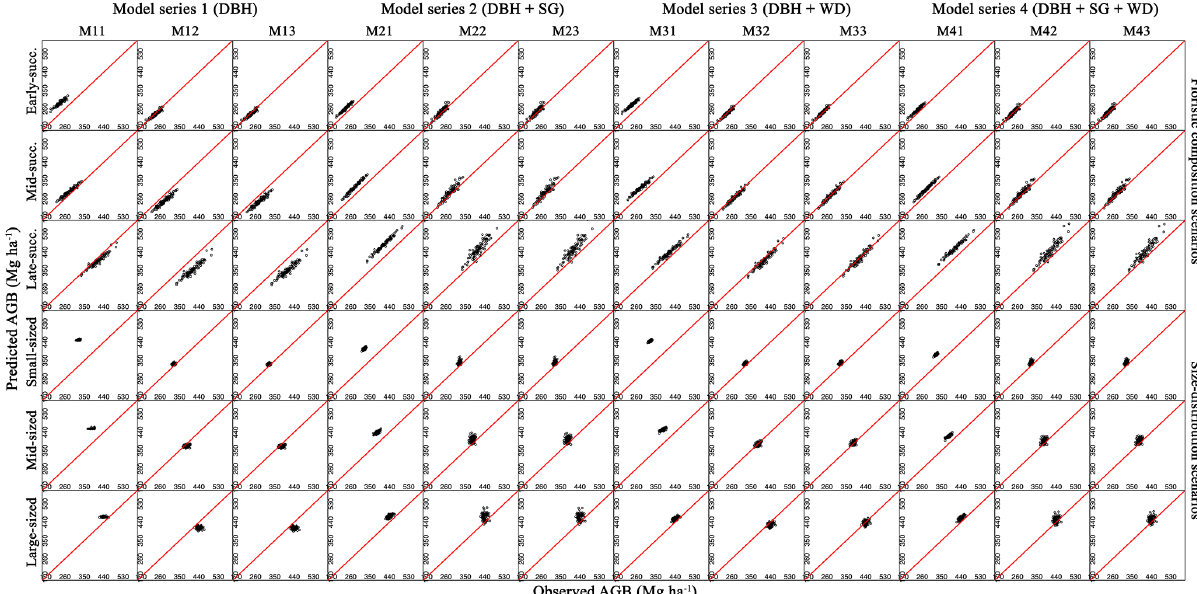
Figure 3. Predicted vs. observed aboveground biomass (AGB) along six forest scenarios composed of 100 1ha plots. The line of equality (1 : 1 line) is shown as a red/straight line. Forest scenarios were designed to reflect landscape-level variations in floristic composition and size distribution of trees, typical of central Amazonian terra firme forests. Floristic composition and size-distribution scenarios followed the sampling scheme described in Sect. 2.4.2 (Fig. 2) of this study. Models’ predictors: diameter at breast height (DBH) (cm), species’ successional group (SG) (pioneers, mid- and late successional) and wood density (WD) (gcm − 3 ) . See Table 2 for the variance modeling approach of different equations. Note that models containing tree total height ( H) as predictor were excluded